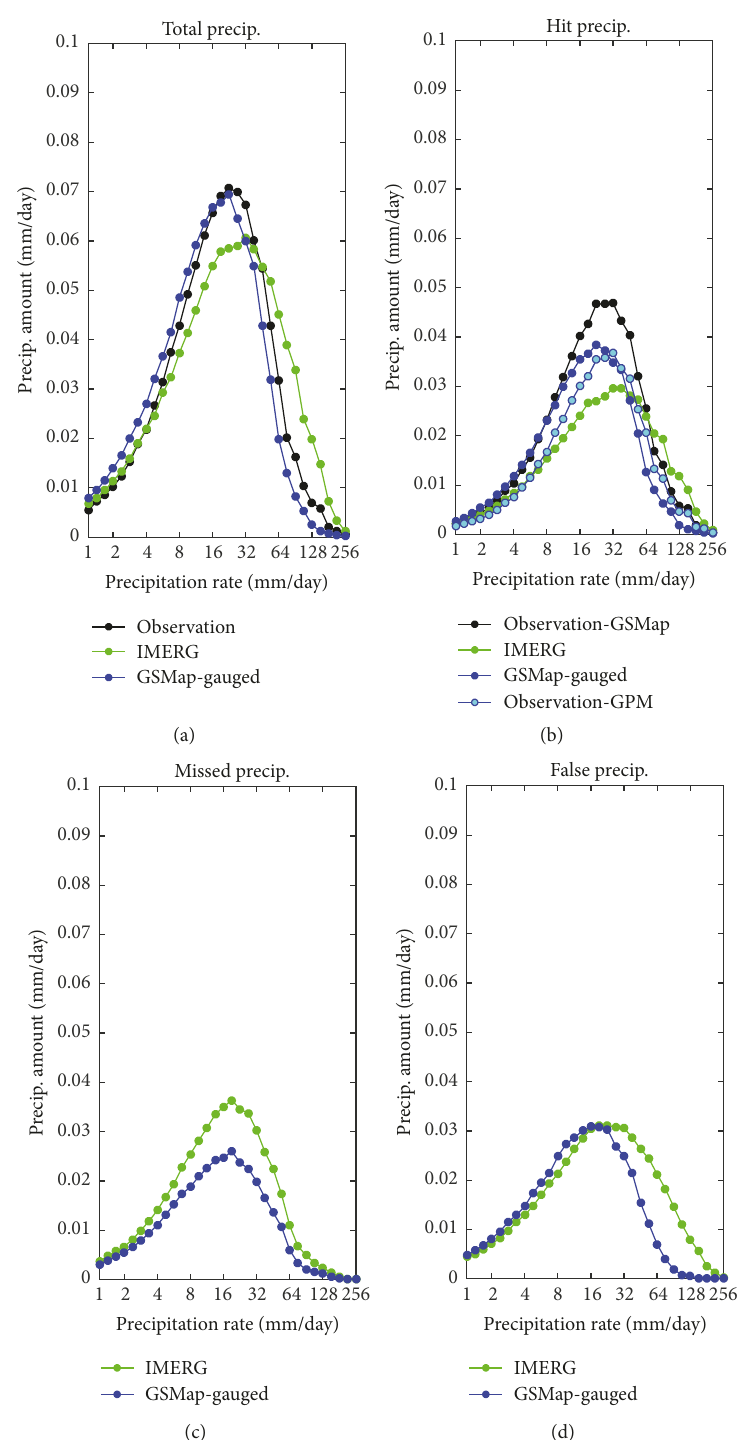
Figure 6: The intensity distribution of the total precipitation as well as the hit, missed, and false precipitation.